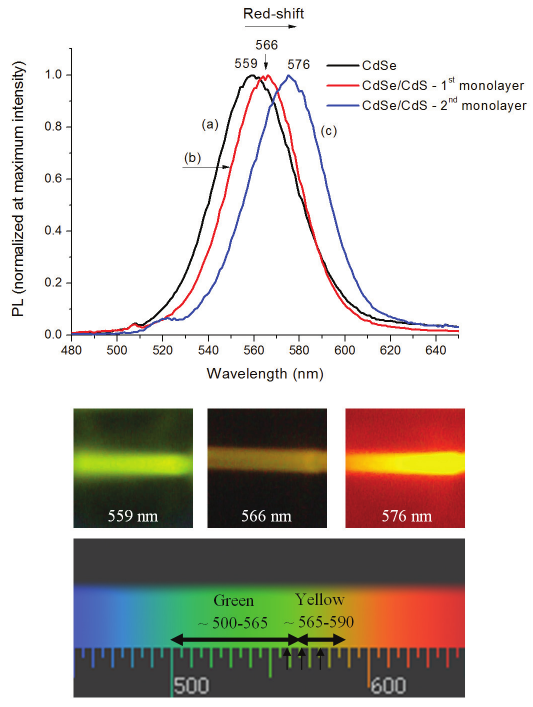
Figure 3. Fluorescence spectra and images of CdSe core (a), CdSe/CdS – 1 st monolayer (b) and CdSe/CdS – 2 nd monolayer (c) in aqueous colloidal solution excited by laser source at = 442 nm (normalized intensities). λ excitation